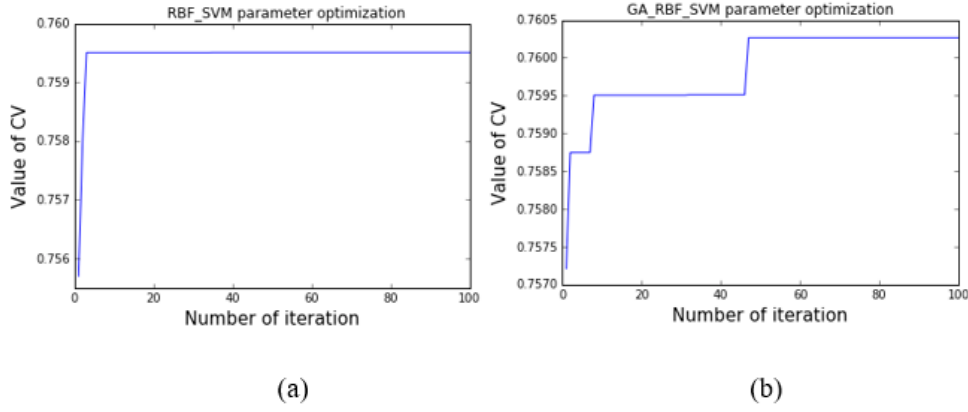
Figure 11. The accuracy values of cross-validation vs number of iteration ( a ) for SVM model and ( b ) for GA-SVM model.